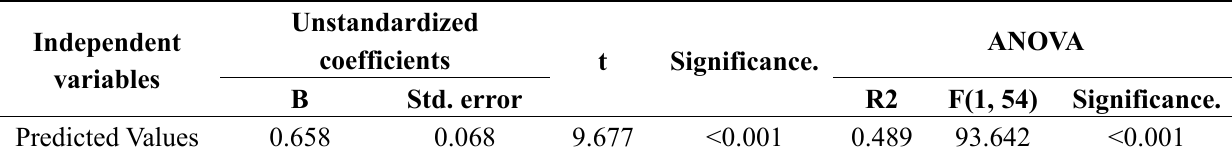
Figure 5. Relationship between the simulated values and the predicted values for the amount of heat removal during the unoccupied period. Table 6. ANOVA test result between the simulated values and the predicted